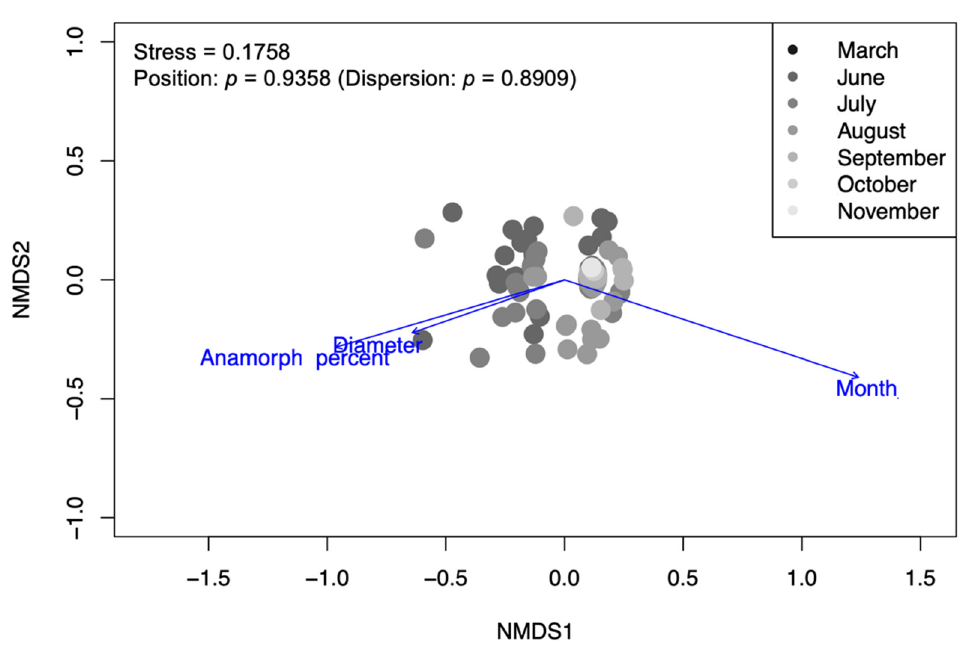
Figure 3. NMDS results showing the relationships between environmental variables and insect community dissimilarity on Quercus serrata logs.